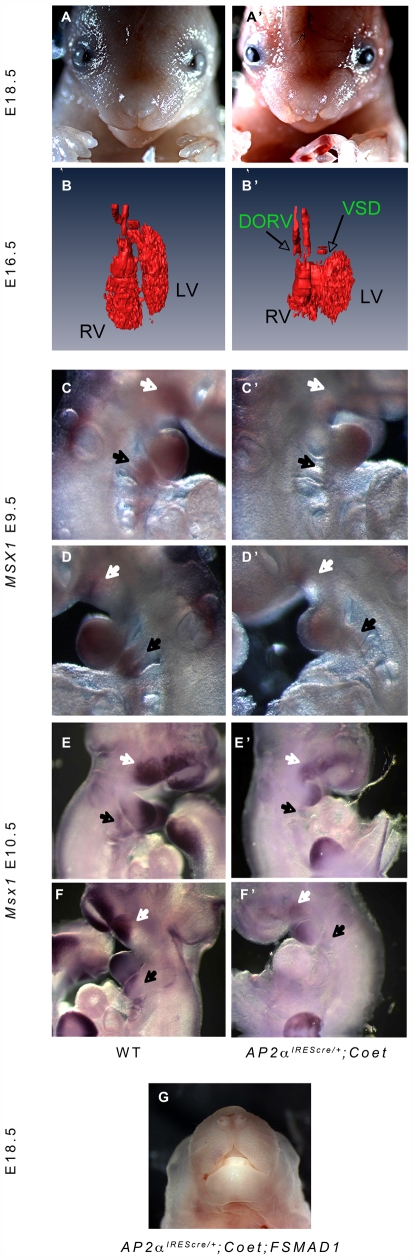
Ectopic expression of Tbx1 in mouse embryos suppresses the Smad1 pathway in vivo.a–a') A Ap2aIRESCre/+;Coet embryo (a') at E18.5 shows bilateral cleft lip, compared with a control littermate (a). b–b') Three-dimensional reconstruction from digital images of histological sections of E16.5 hearts from control (b) and Ap2aIRESCre/+;Coet embryos. The cavities of the right (RV) and left (LV) ventricles, as well as the great arteries are shown in red. Note the large ventricular septal defect (VSD), and the common origine of the aorta and pulmonary arteries from the right ventricle, a condition known as double outlet right ventricle (DORV). (c–f') Whole-mount in situ hybridization analysis of Msx1 expression in WT (c, d, e, f) and Ap2aIRESCre/+;Coet embryos (c', d', e', f') at E9.5 (c–d') and E10.5 (e–f'). Mutant embryos show reduced expression in the maxillary region (white arrows) and in the second pharyngeal arch (black arrows). (g) Cleft lip present in Ap2aIRESCre/+;Coet embryos (compare with panel a) is rescued by the FSMAD1 transgene.